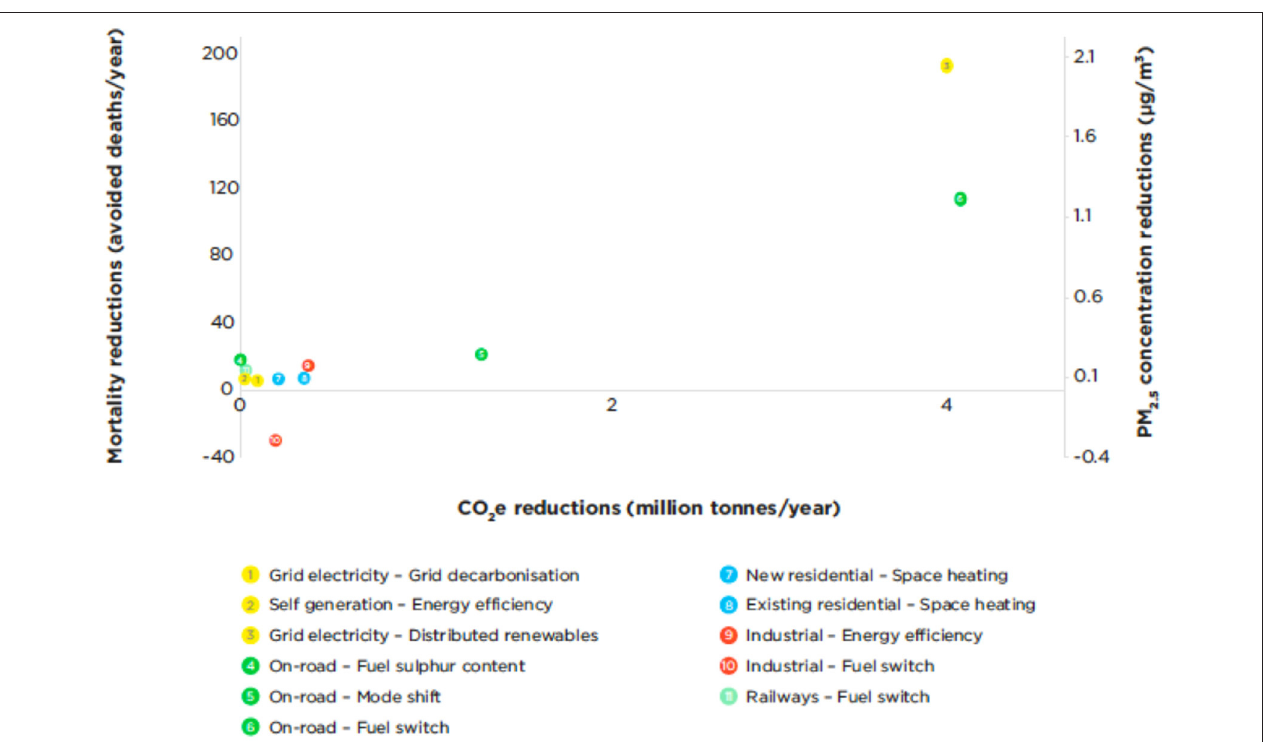
FIGURE 6 | Estimated impacts of the Buenos Aires “Ambitious” Scenario on annual average PM 2.5 concentration and the annual number of PM 2.5 -attributable premature deaths for